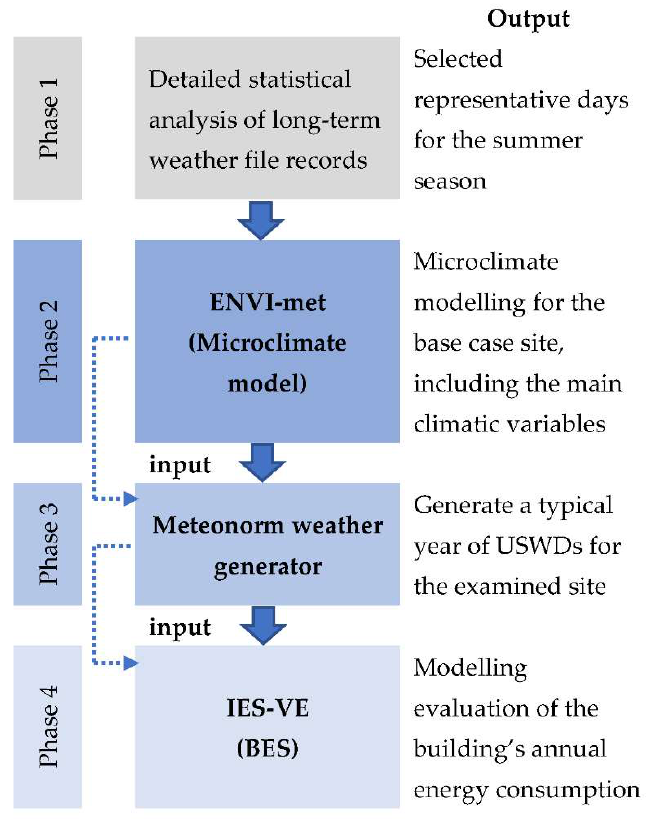
Figure 1. Methodological approach.